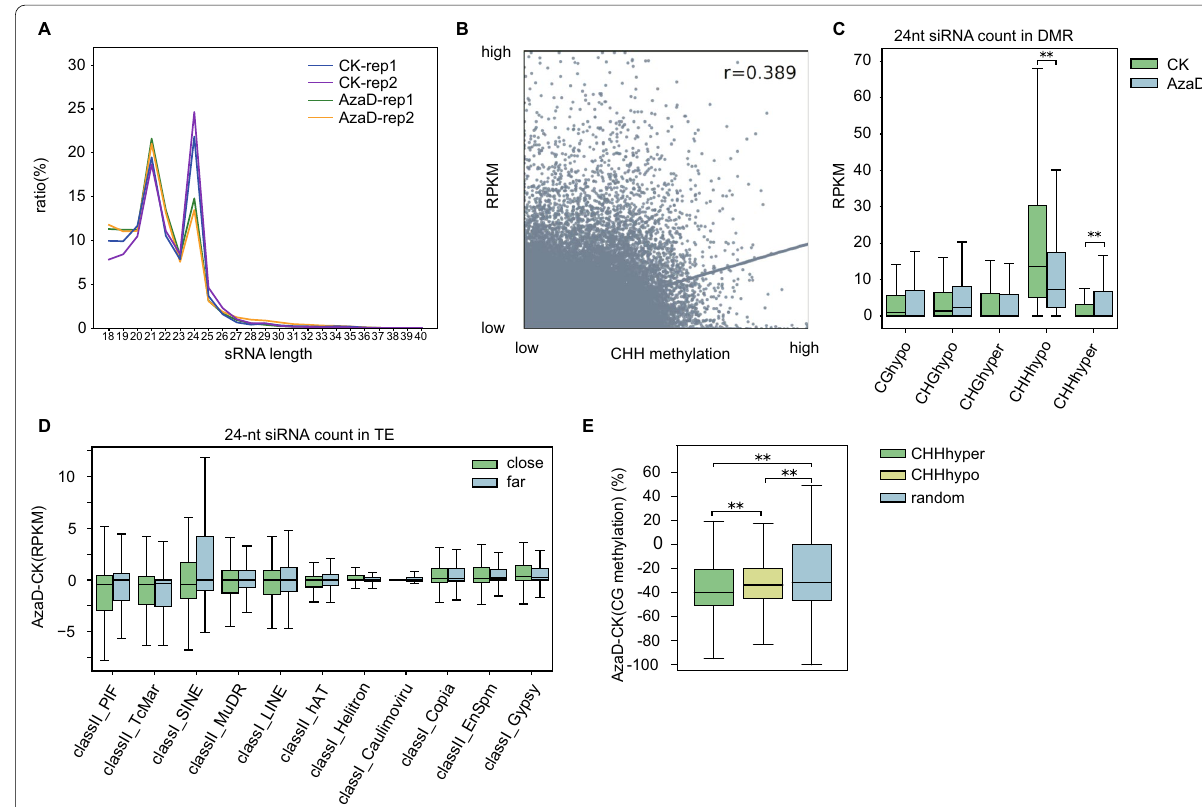
Fig. 4 24-nt siRNAs were altered as a response to CG methylation loss. a siRNA profile of AzaD treated and CK rice. 21–22-nt siRNAs were up-regulated while 24-nt siRNA were down-regulated after AzaD treatment. b Correlation between CHH methylation level and 24-nt siRNA abundance in DMRs. c 24-nt siRNA RPKM in different DMRs. The 24-nt siRNA count was associated with CHH methylation. d 24-nt siRNA RPKM changes of close and far TEs from different TE families. The distribution pattern was highly similar to that of CHH methylation in TEs from different families. e CG methylation level changes in CHH hyper DMRs, CHH hypo DMRs, and random regions. * p < 0.05, ** p < 0.01 by Student’s t-test